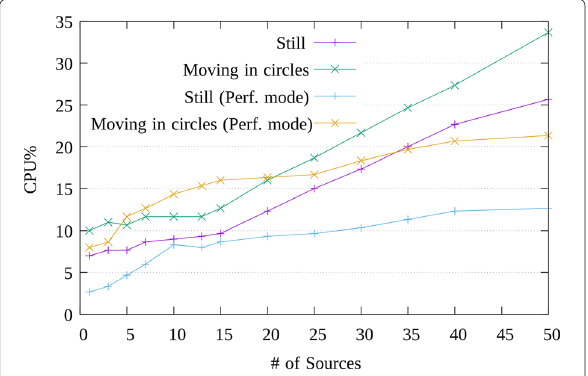
Fig. 7 Soundscape Experience Mobile CPU